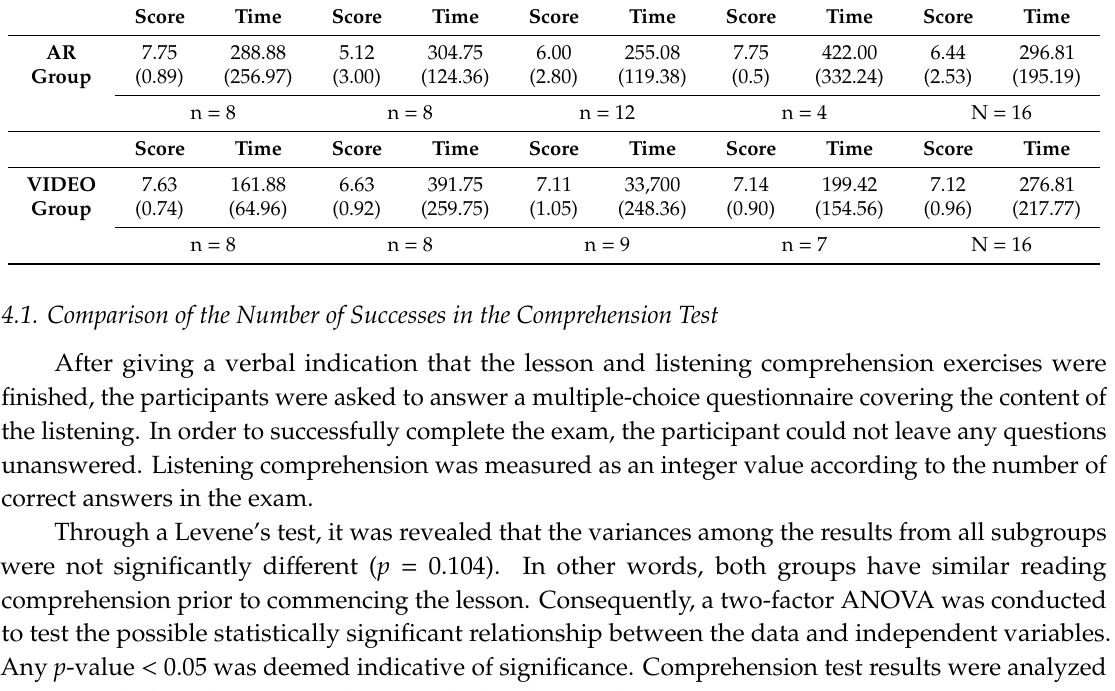
Table 3. Summary of Statistical Description of Data (mean values and standard deviation). Low Boys Girls All Participants